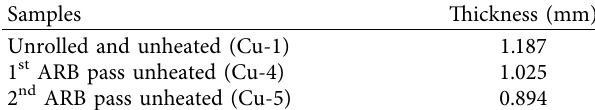
Table 3: ARB experimental results of experiment 2.